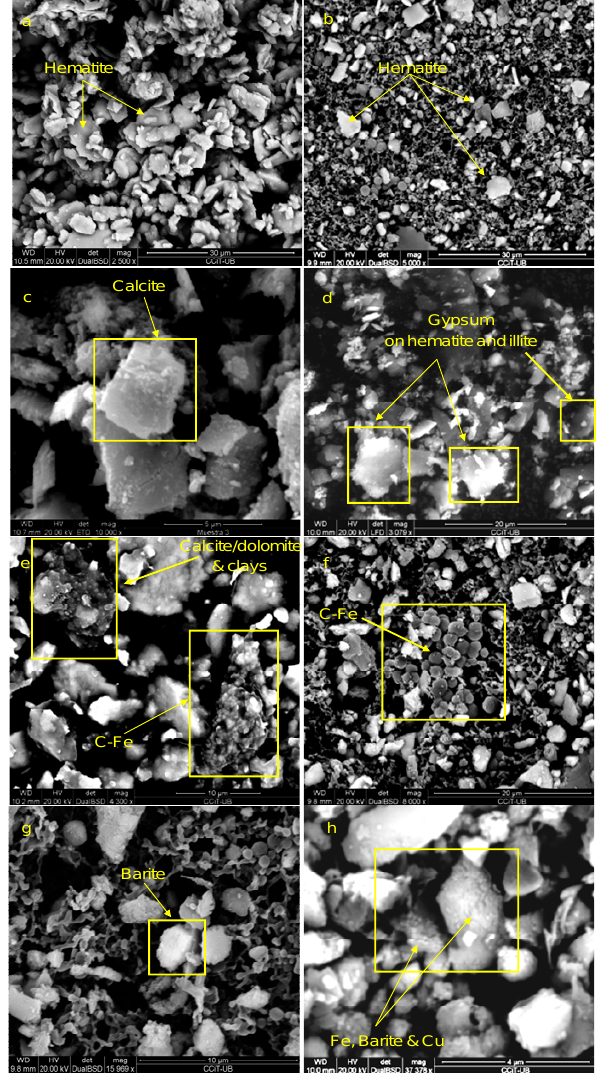
Fig. 7. SEM microphotographs and EDX spectra of PM 10 samples collected at S-L9 and F-L3 platforms; (a) general view of the PM collected at S-L9 platform showing the predominance of laminate hematite from wheel/rail erosion; (b) general view of the PM col- lected at L-F3 platform showing similar grains but also the occur- rence of rounded and rough particles; (c) discrete calcite crystal (4– 5µm), at S-L9; (d) traces of fine gypsum on hematite and illite sur- faces at S-L9; (e) aggregates of calcite/dolomite, clays and C-Fe at S-L9; (f) detail of rounded and melted C-Fe particles < 2.5µm at L-F3; (g) discrete barite particle (4–5µm) from brake pads erosion; and (h) rough-surface Fe particles with traces of Barite and Cu aris- ing from friction between wheels and brake pads.